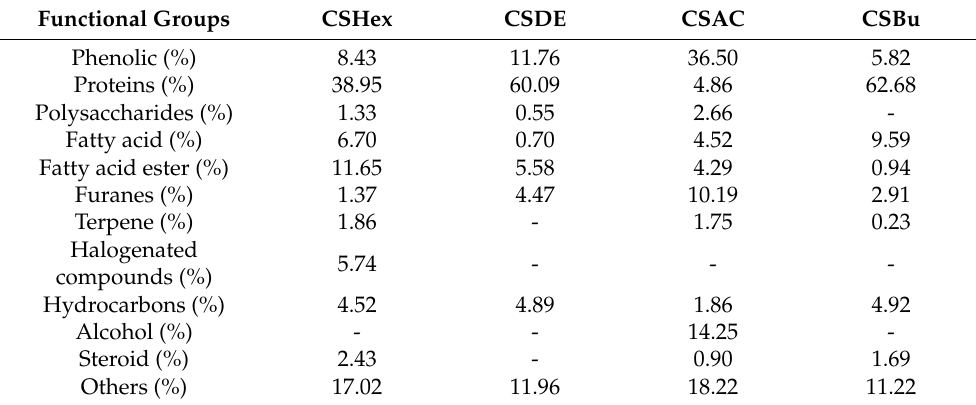
Table 3. Normalized relative percentage grouped by class of functional group of the Py-GC/MS peak areas at 600 ◦ C.